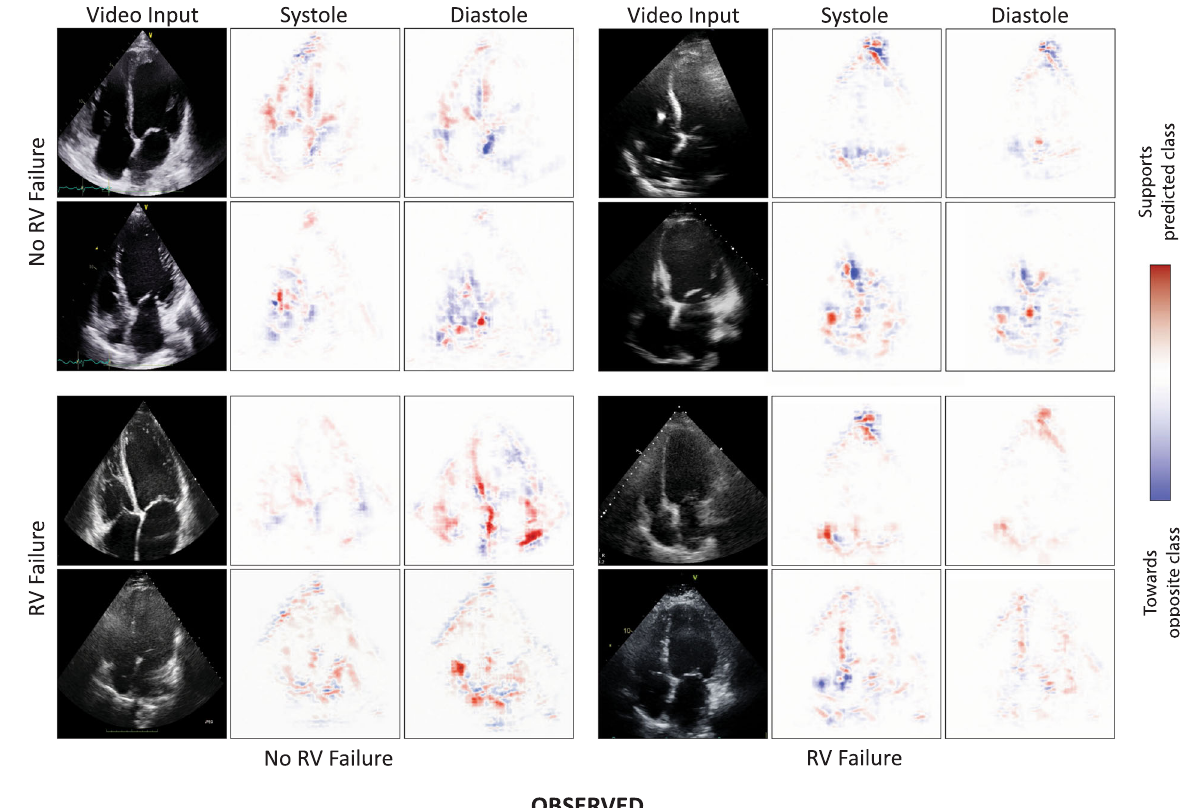
Fig. 3 Analysis of saliency maps from pre-operative echocardiograms. Representative input videos and visualizations for both systolic and diastolic phases of the cardiac cycle across patients with and without RV failure, in the form of a confusion matrix. True positives (bottom right quadrant), false positives (bottom left quadrant), true negatives (top left quadrant), and false negative examples (top right quadrant). Colour scale for each quadrant represents regions that contributed most to the predicted class (red) and those that pushed predicted probability away from the predicted class